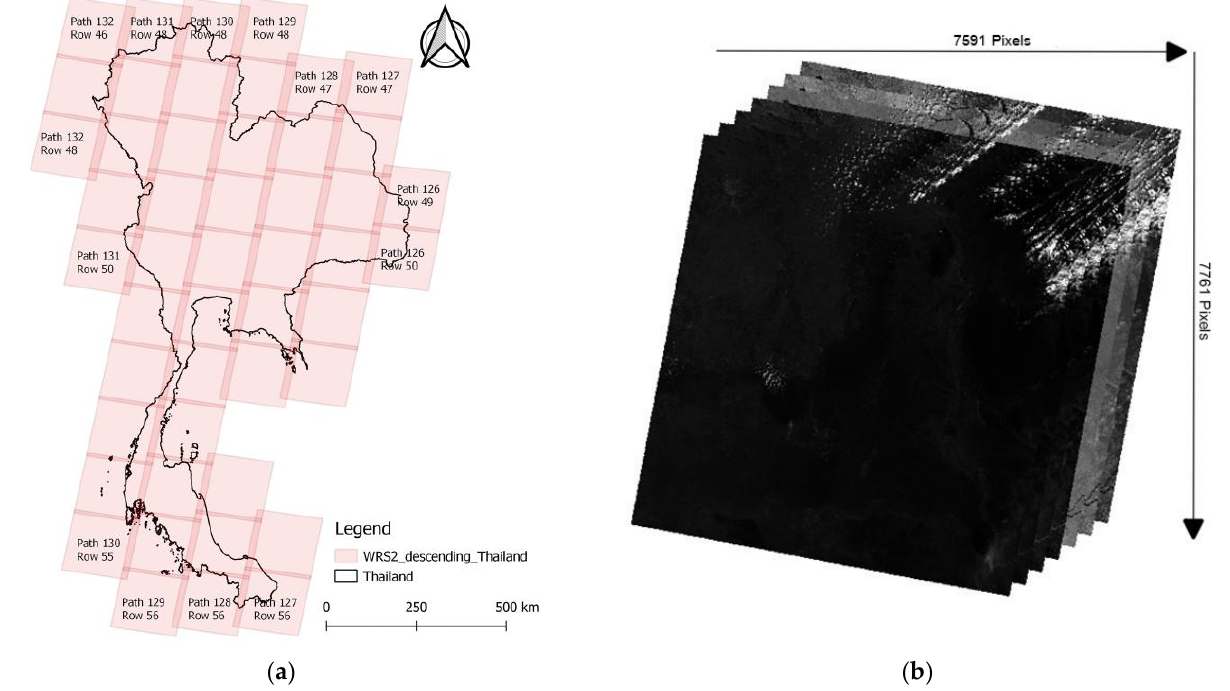
Figure 1. Landsat 8 WRS 2 Descending Path Row covering Thailand ( a ) and seven spectral bands of Landsat 8 ( b ).